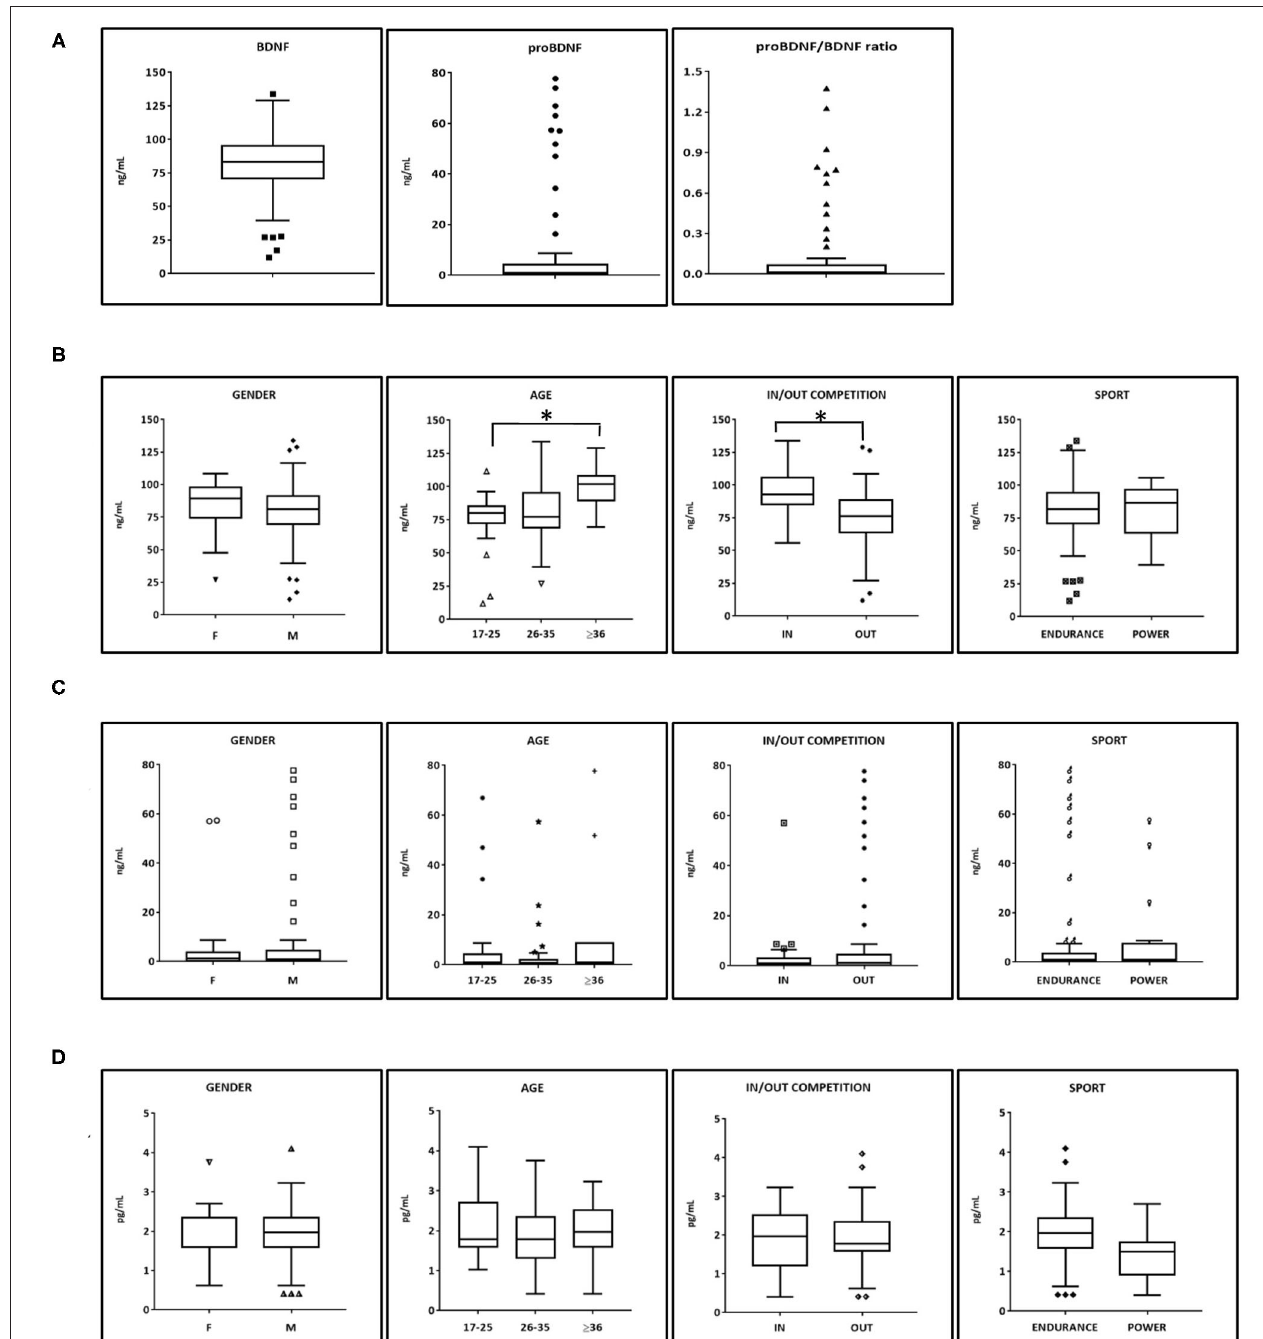
FIGURE 1 | BDNF, proBDNF, and beta-NGF serum levels in athletes. (A) BDNF, proBDNF, and their ratio ( N = 88). (B) BDNF serum levels among categories (male N = 70, females N = 18, Endurance N = 70 Power N = 18). Age and time of collection show statistical significance as resulted from Mann-Whitney test. (C) proBDNF serum levels among categories. (D) beta-NGF serum levels among categories. BDNF, brain derived neurotrophic factor; proBDNF, pro-brain derived neurotrophic factor; beta-NGF, beta-nerve growth factor. Symbols outside the box plots indicate the